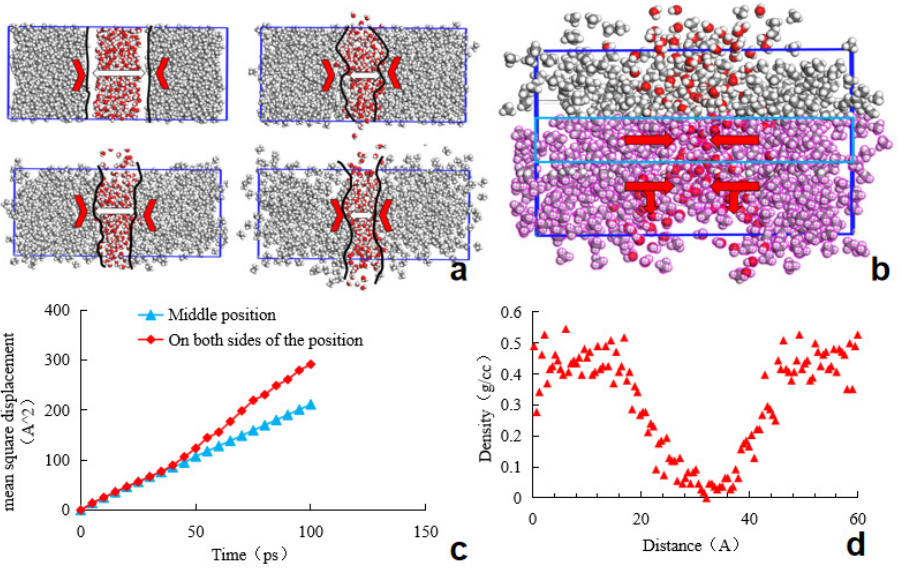
Figure 8. Free motion process of molecules at oil film positions at different moments. ( a ) Deformation of liquid film molecules during coalescence of oil droplets. ( b ) Movement trend of middle and side molecules. ( c ) Root mean square displacement of intermediate and bilateral molecules. ( d ) Density distribution of oil molecules in the system.